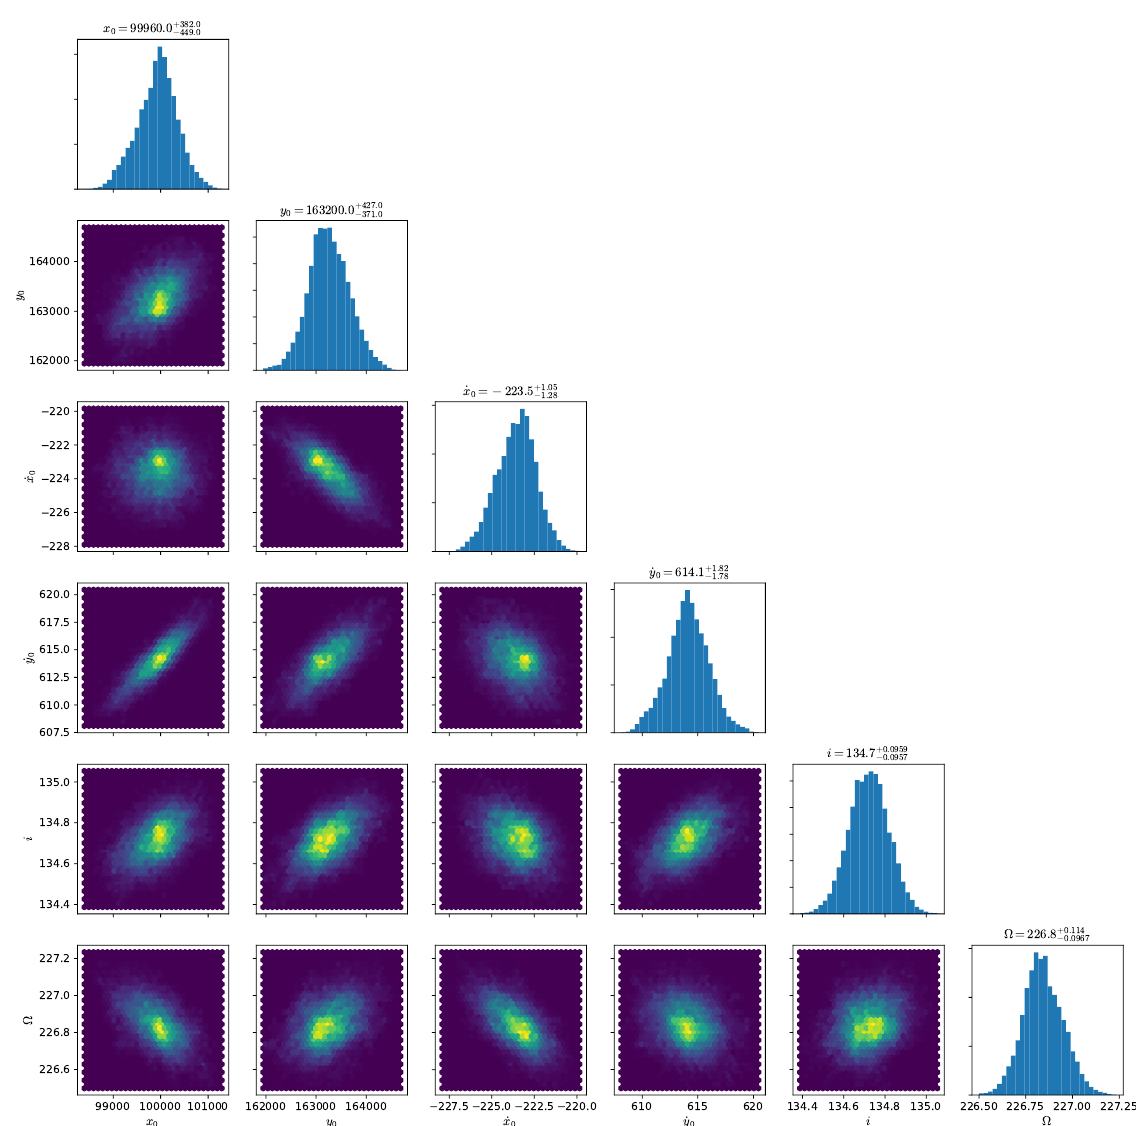
Figure A1. The posterior distribution of the orbital parameters of the S2 star. The initial position vector components ( x 0 , y 0 ) are given in the units of the gravitational radius corresponding to the mass of 10 6 M (which is 1,476,625 km). The initial velocity components ( ˙ x 0 , ˙ y 0 ) are given in kms − 1 . The inclination i and the longitude of the ascending node Ω are given in